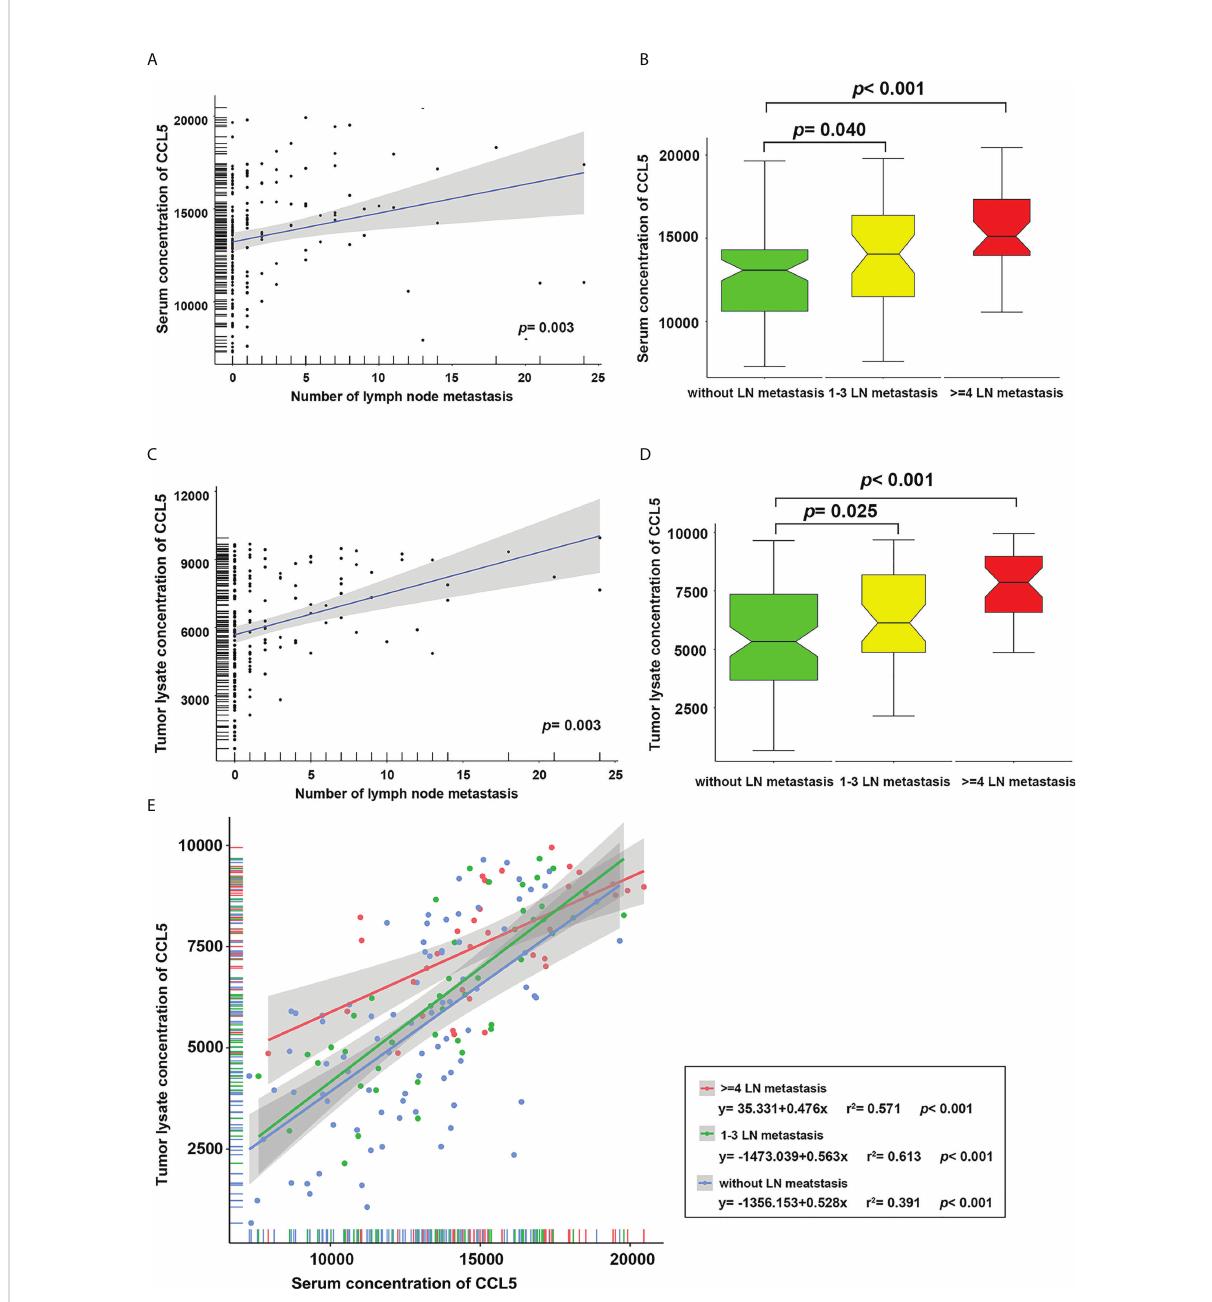
FIGURE 2 The level of CCL5 in serum (A) and tumor tissue lysate (C) was positively correlated with the number of lymph node metastases. The levels of CCL5 in serum (B) and tumor tissue lysate (D) in patients with 1-3 and ≥ 4 lymph node metastases were signi fi cantly higher than those in the lymph node-negative group. (E) Regardless of the number of axillary lymph node metastases, the level of CCL5 in serum was positively correlated with that in tumor